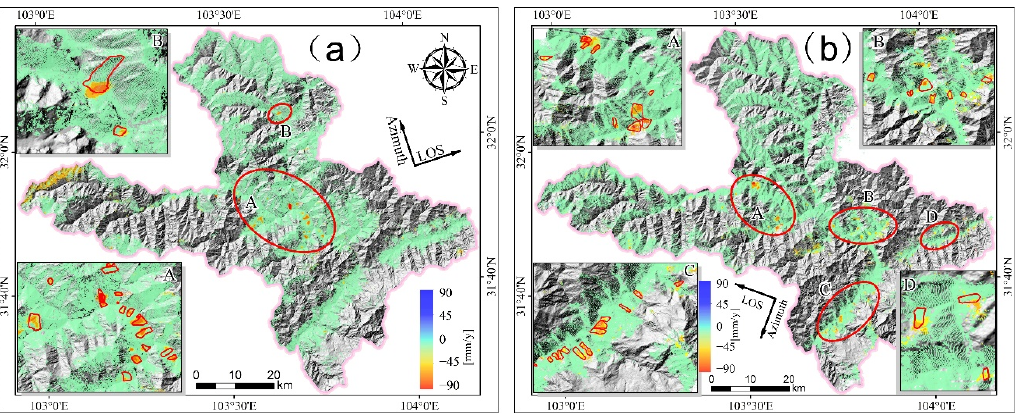
Figure 2. InSAR identifies the distribution of landslides: ( a ) Average annual deformation rate from ascending orbits of the Sentinel-1A satellite (landslides are concentrated in A and B); ( b ) Average annual deformation rate from descending orbits of the Sentinel-1A satellite (landslides are concentrated in A, B, C and D).